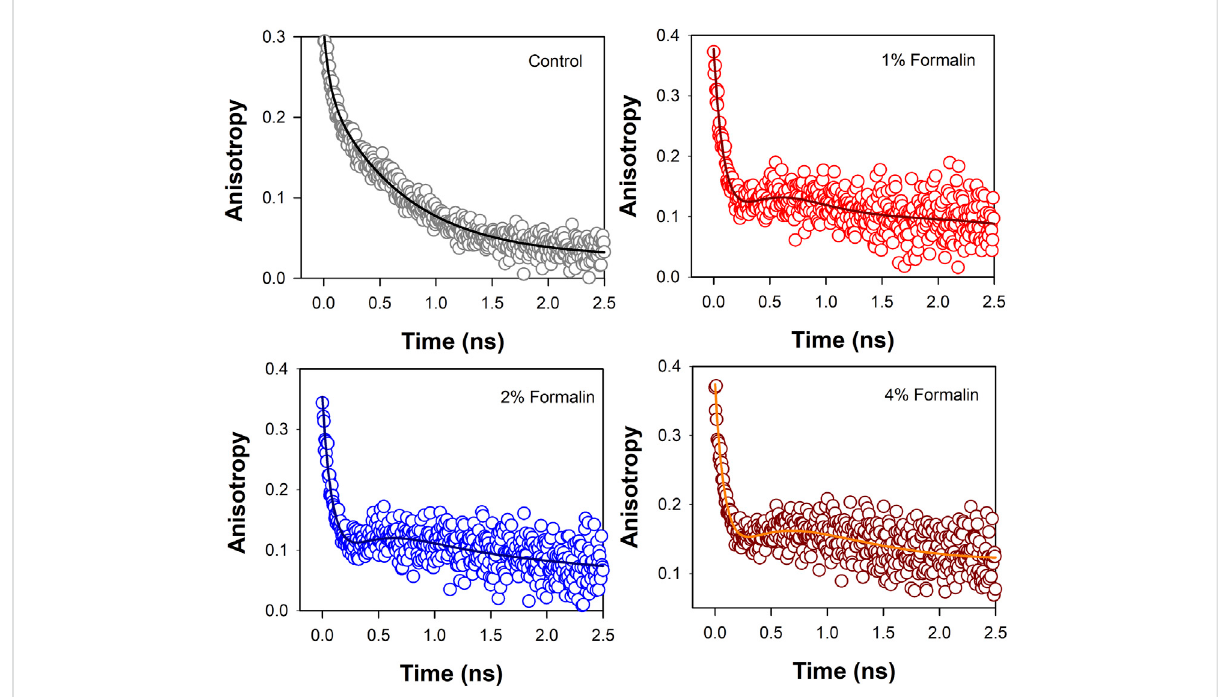
FIGURE 5 Anisotropy decay [r(t)] of ANS in CHT in absence and presence of formalin.